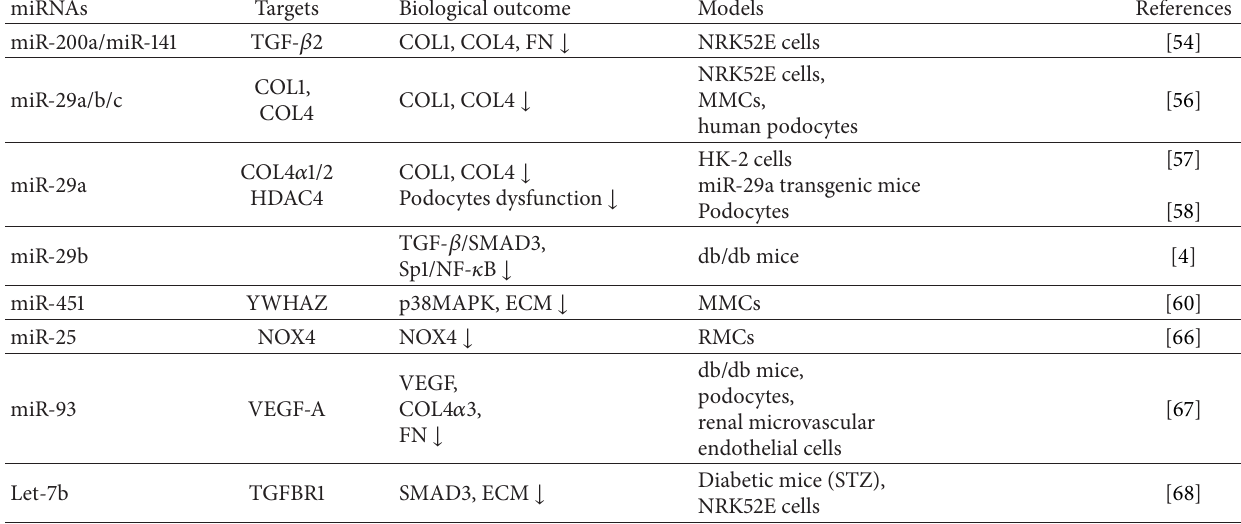
TGFBR1: transforming growth factor beta receptor 1; VEGF-A: vascular endothelial growth factor A; Sp1: specificity protein 1; HDAC4: histone deacetylase 4; YWHAZ: tyrosine 3 monooxygenase/tryptophan 5-monooxygenase activation protein, zeta; NOX4: NADPH oxidase subunit 4; NRK52E cells: rat renal proximal tubular cell